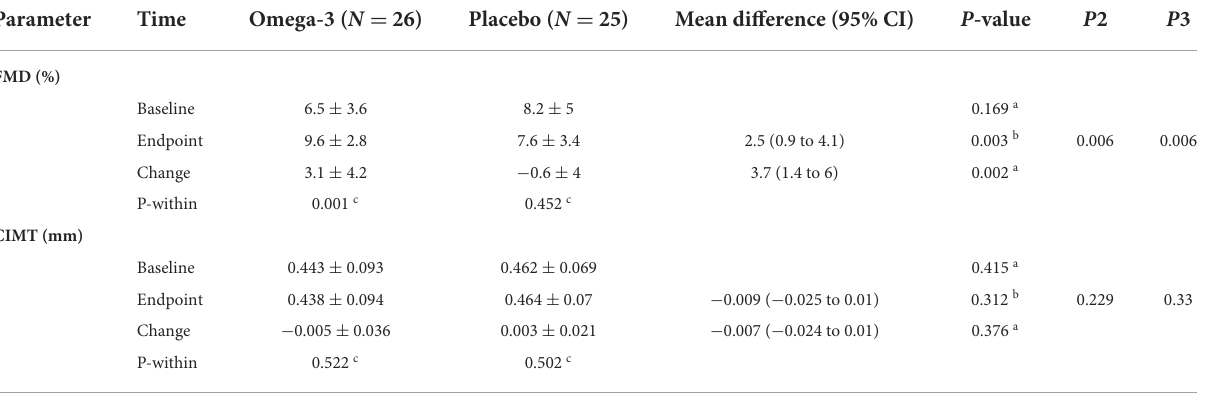
TABLE 2 Effect of omega-3 supplementation on endothelial function and vascular structure. Parameter